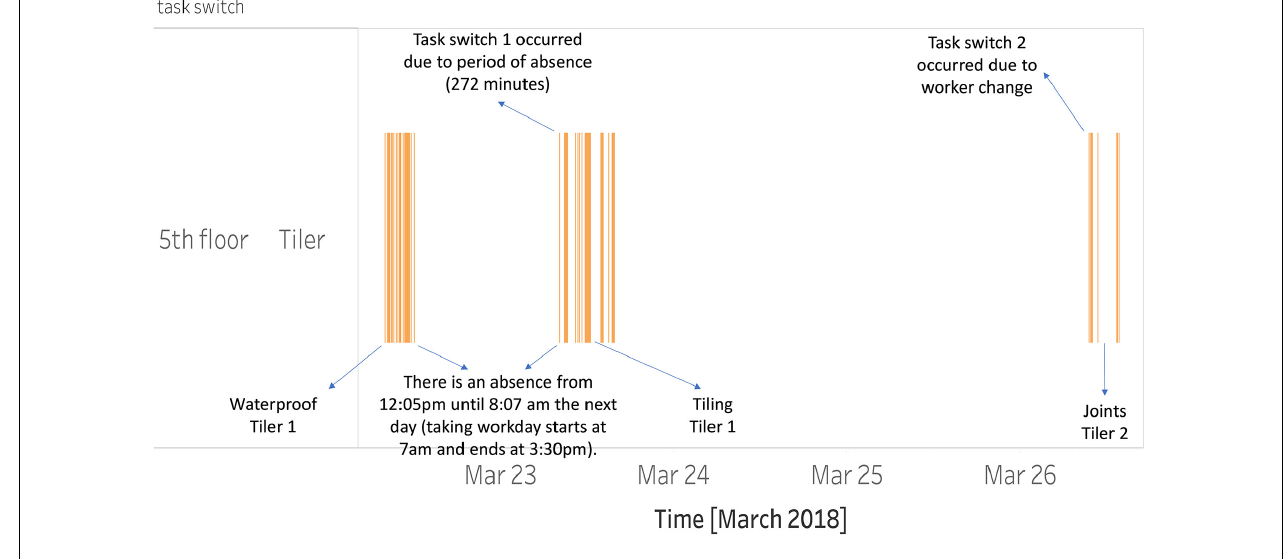
FIGURE 3 | Task switch example for three consecutive tasks on floor 5.